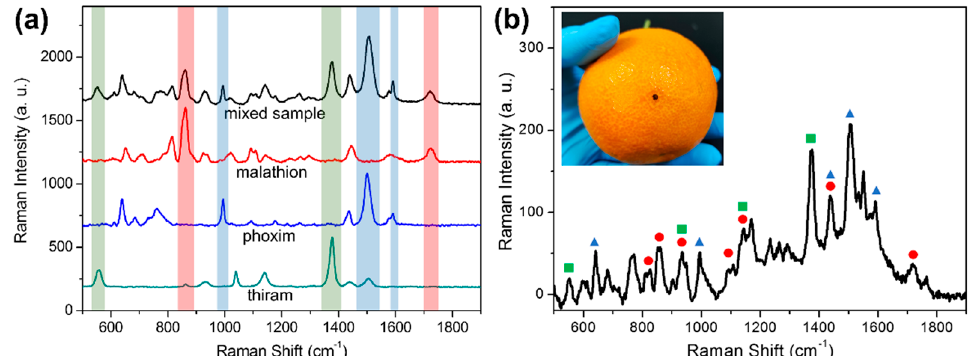
Figure 5. SERS spectra of mixed (black curve) and single pesticides (thiram, malathion, and phoxim) using an AgNPs-PDMS substrate ( a ). SERS spectrum of orange surface spiked with mixed pesticides after swab sampling using an AgNPs − PDMS substrate; characteristic SERS bands are labeled for each pesticide: thiram (green square), malathion (red circle), and phoxim (blue triangle) ( b ). Inset of ( b ): photo of performing swab sampling using the flexible SERS substrate.